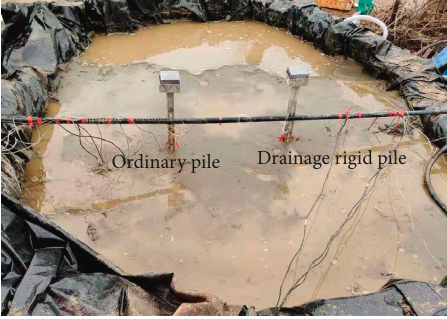
Figure 6: Final schematic of the site.